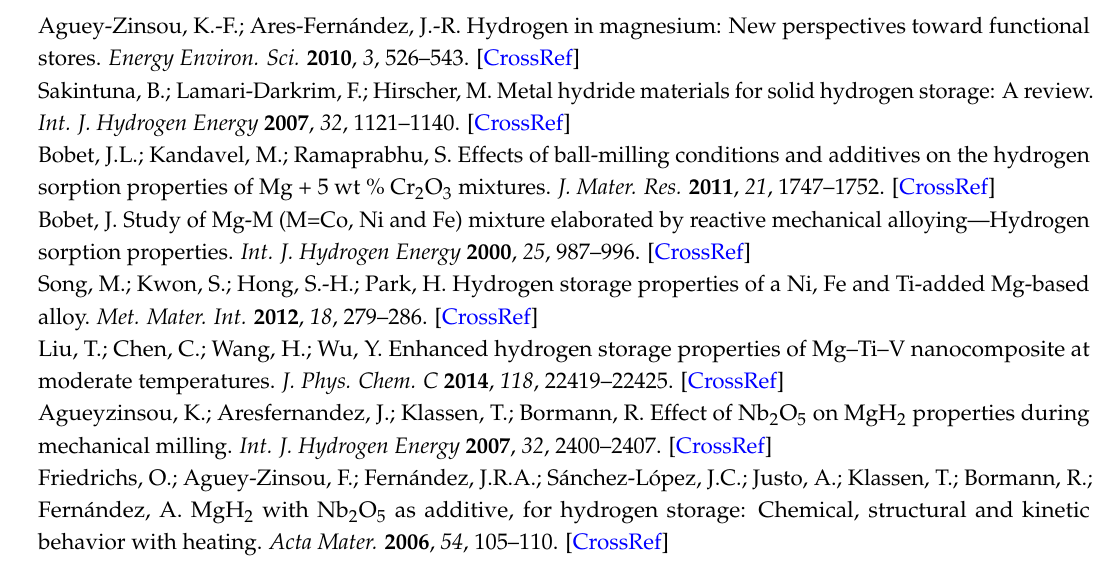
Figure S1: Amount of magnesium deposition at the surface of the Ni foam as function of time and corresponding charge passed through the electrochemical cell. The amount of magnesium was determined from ICP-OES analysis, Figure S2: XRD pattern of Ti/15 h after 200 ◦ C hydrogenation, Figure S3: Hydrogen desorption profile of the Ni foam, Figure S4: Hydrogen desorption profiles obtained by MS at various heating rates (5, 10, and 20 ◦ C · min − 1 ) of the magnesium nanoparticle deposited at the Ni and Ti substrates. Only the first peak corresponding to hydrogen release from the magnesium nanoparticles supported on the Ni substrate was used to calculate E a